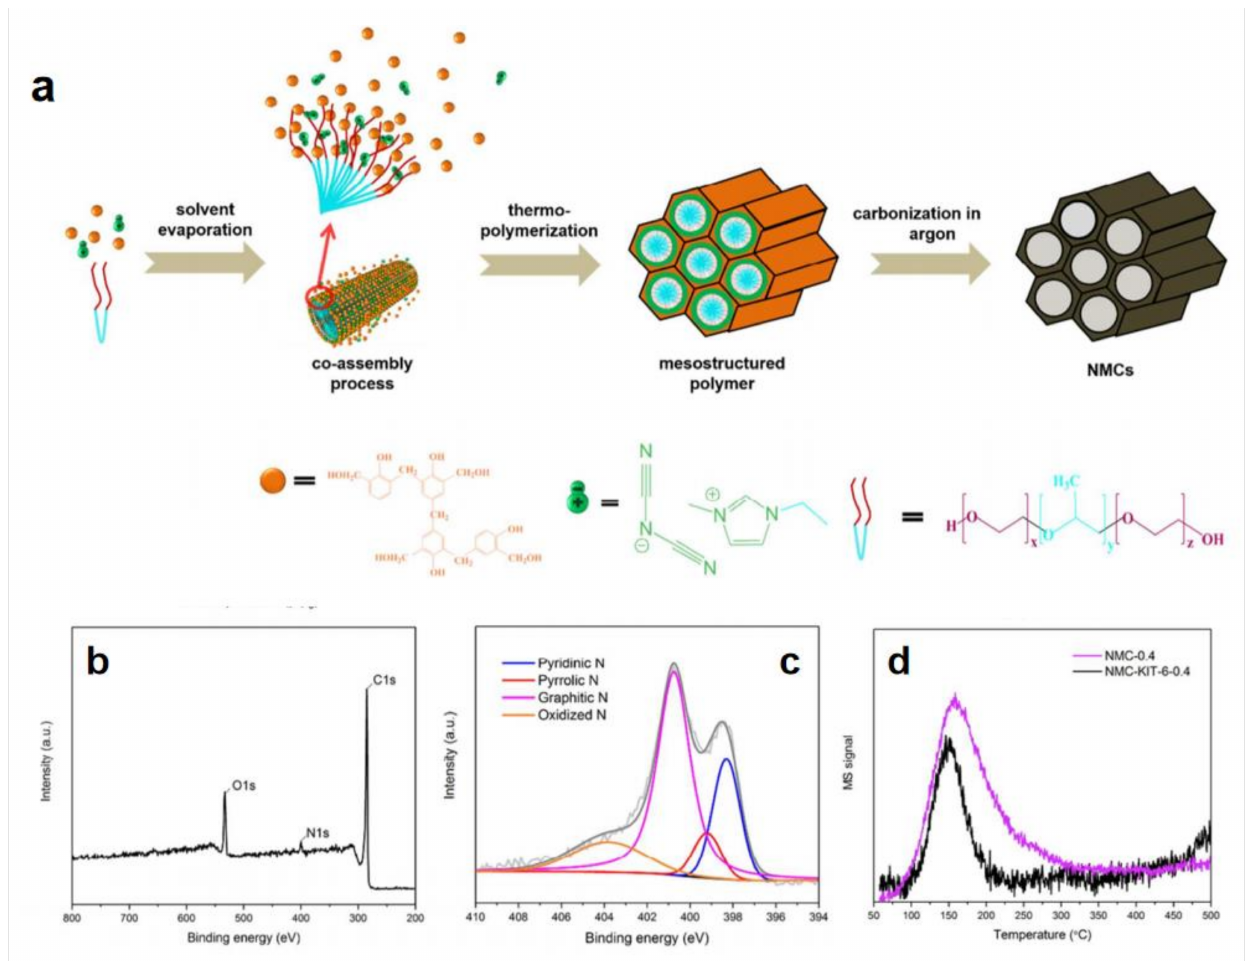
Figure 3. Schematic illustration of synthesis of IL-assisted porous nitrogen-rich carbon materials ( a ), their survey spectra ( b ) and N 1s ( c ), XPS spectra as well as CO 2 − TPD ( d ). Reprinted with permission from ref. [72], copyright 2017 ACS